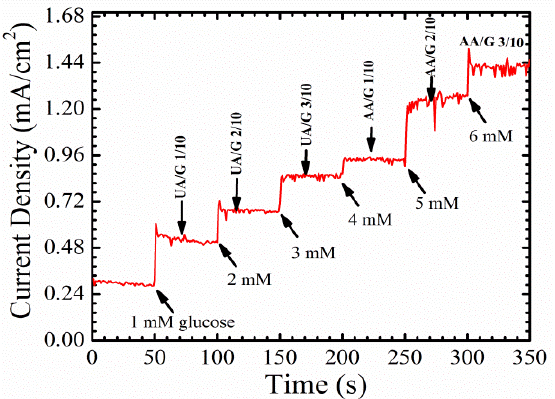
Figure 11. The amperometric response of the glucose sensor with different electroactive analytical solutions, uric acid and ascorbic acid, to examine the selectivity of the electrochemical sensor.